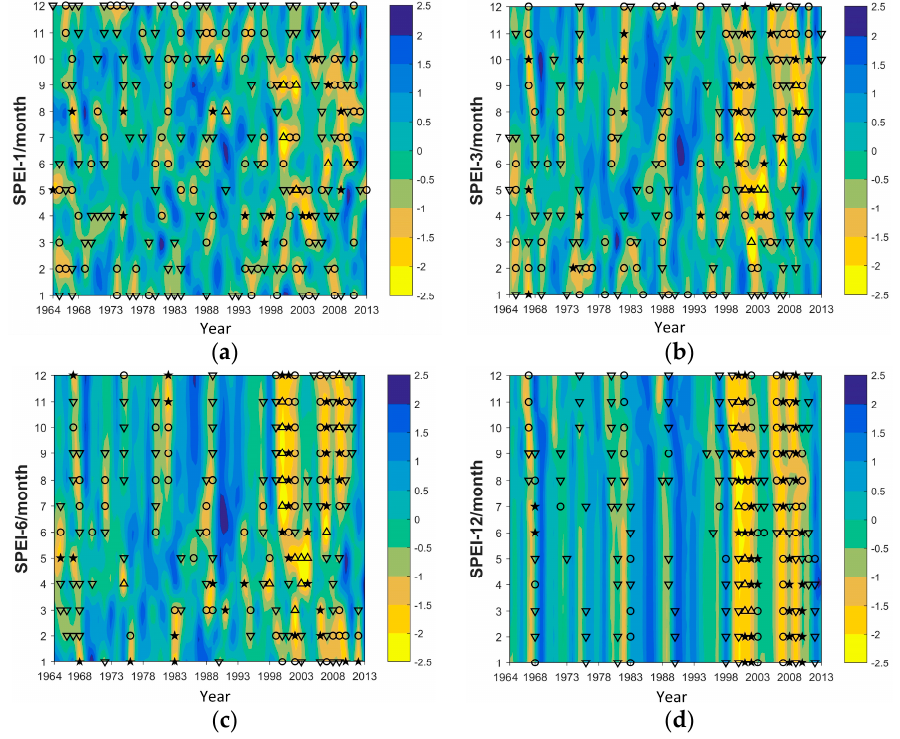
Figure 3. Monthly contours of SPEI-1 ( a ); SPEI-3 ( b ); SPEI-6 ( c ); and SPEI-12 ( d ) and the mean droughts events in different severity grades across 15 meteorological stations during 1964–2013. Note: (cid:53) , and (cid:52) represents the mild, moderate, severe, and extreme drought,